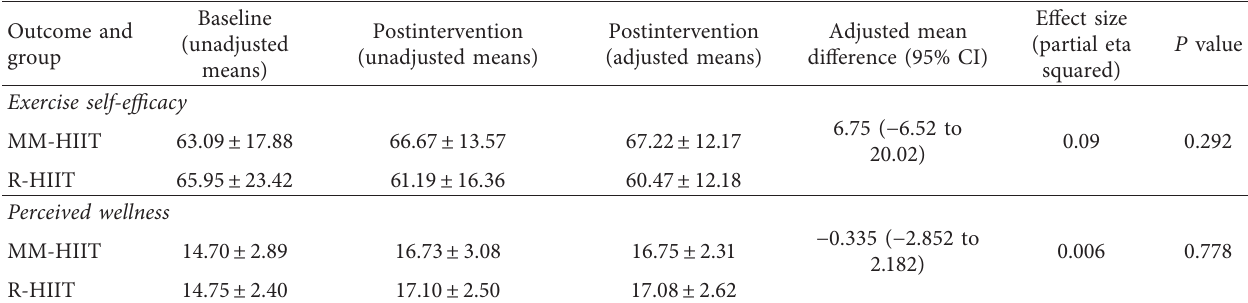
Plus-minus values are means ± SD with postintervention means being adjusted for covariates of baseline values, and data in parentheses are 95% CI. Mean difference is based on rowing group minus multimodal group after the intervention. MM-HIIT � multimodal high-intensity interval training; R- HIIT � rowing high-intensity interval